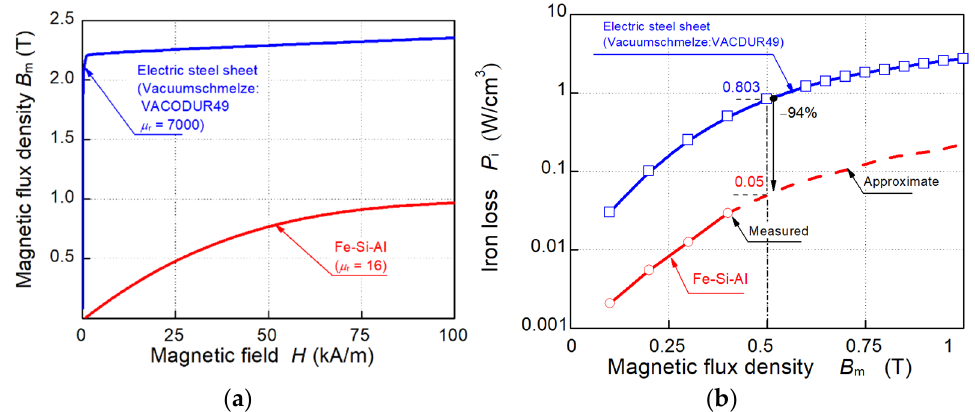
Figure 7. Magnetic characteristic of magnetic composite material ( a ) DC magnetic characters; ( b ) iron loss characteristics.